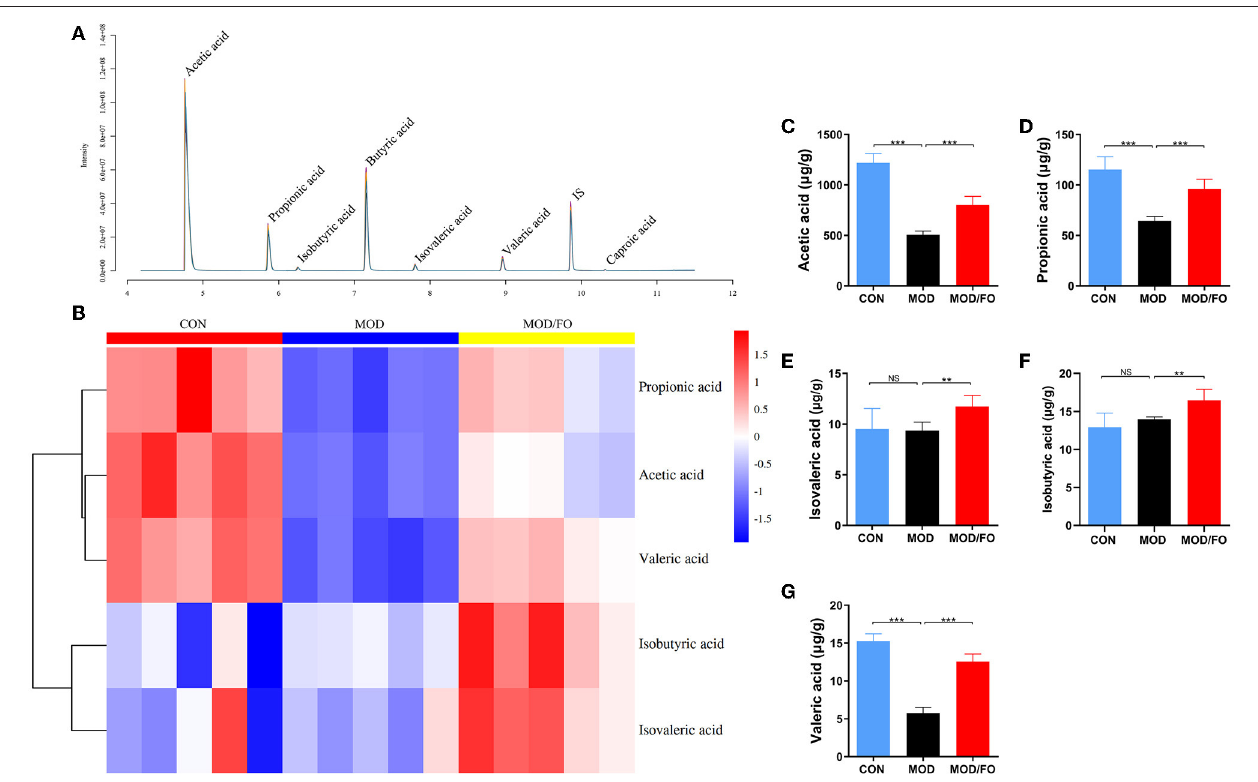
FIGURE 4 | Measurement of the contents of short-chain fatty acids (SCFAs) in fecal intestinal metabolites. (A) Chromatogram of mice stool. (B) Heat map clustering. (C) Determination of levels ( µ g/g) of Acetic acid, Propionic acid (D) , Isovaleric acid (E) , Isobutyric acid (F) , and Valeric acid (G) by gas chromatography-mass spectrometer (GC-MS). Data were presented as mean ± SEM. ** P < 0.01, *** P < 0.001, NS, no